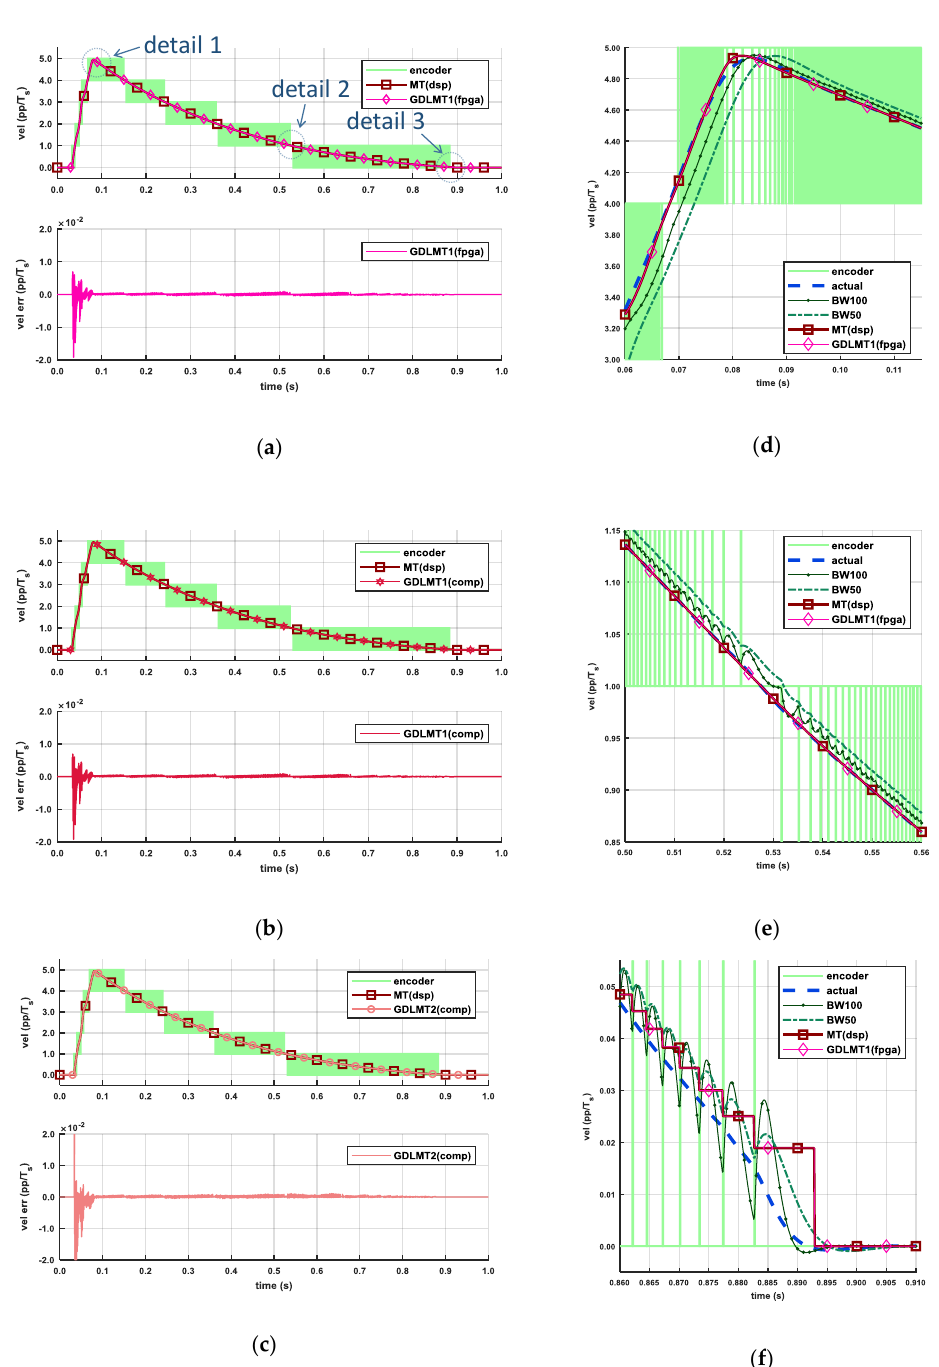
Figure 11. Manual experiment number 1: ( a ) Comparison of the MT velocity and the generalized division-less MT-type algorithm of the first order (GDLMT1) velocity (FPGA version); ( b ) Comparison of the MT velocity and the GDLMT1 velocity (computer version); ( c ) Comparison of the MT velocity and the generalized division-less MT-type algorithm of the second order (GDLMT2) velocity; ( d – f ) Details 1–3 from (a).